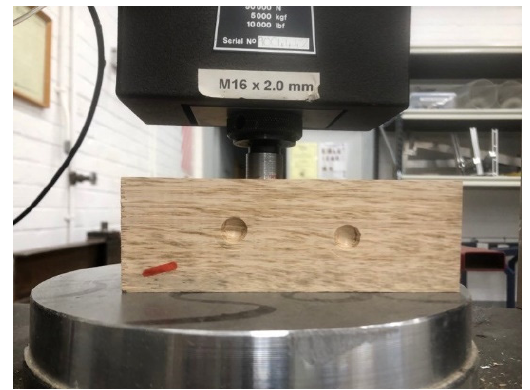
Figure 2. Janka Hardness test on 50 mm thick solid timber sample.